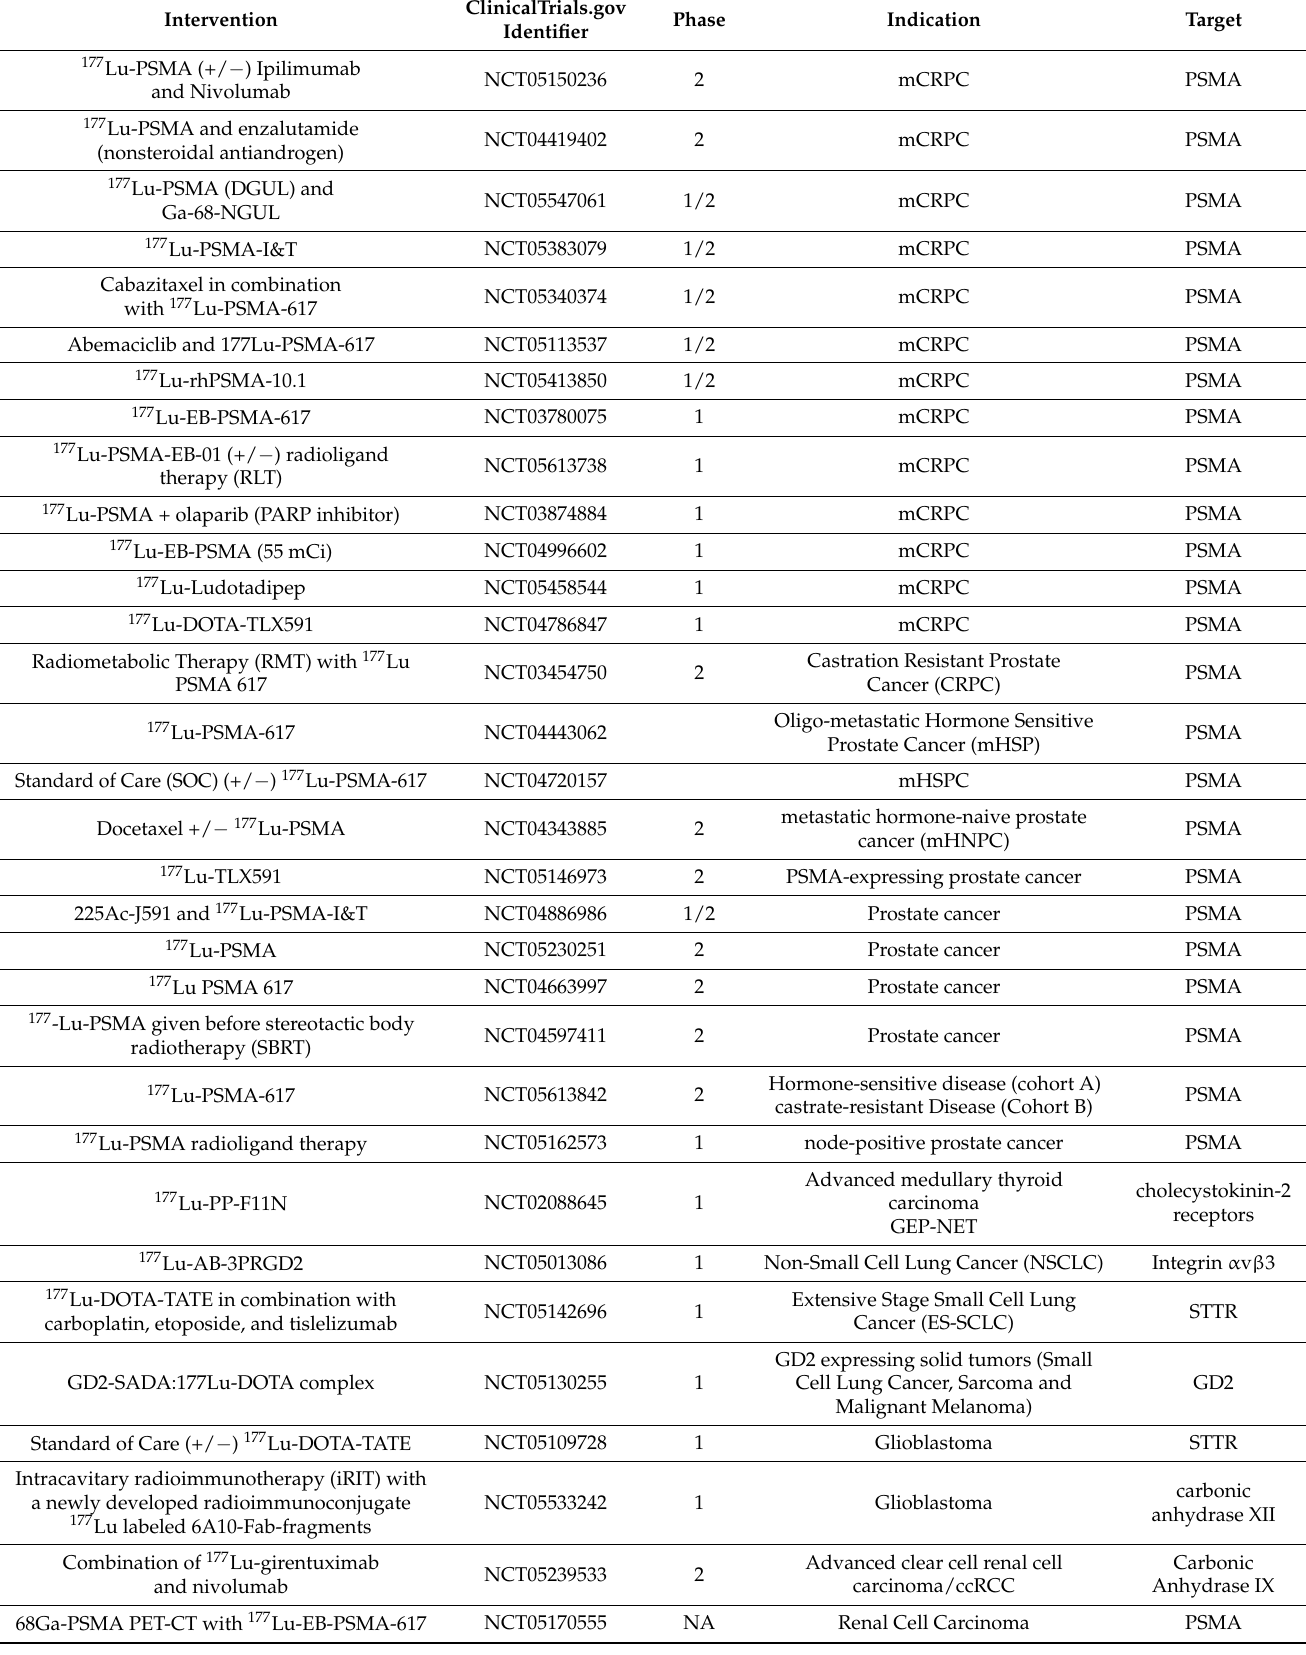
Table 2. Current clinical applications and trials of Lutetium-177 ( 177